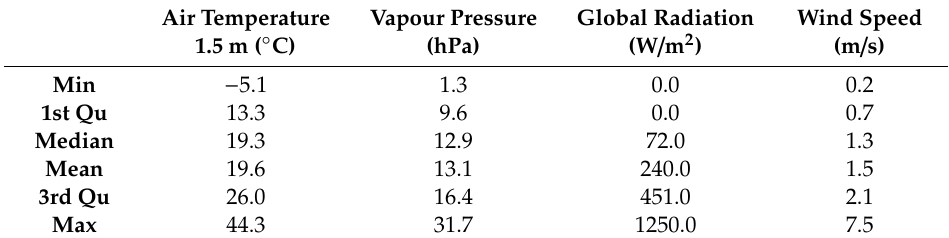
Table 2. Input parameters descriptive